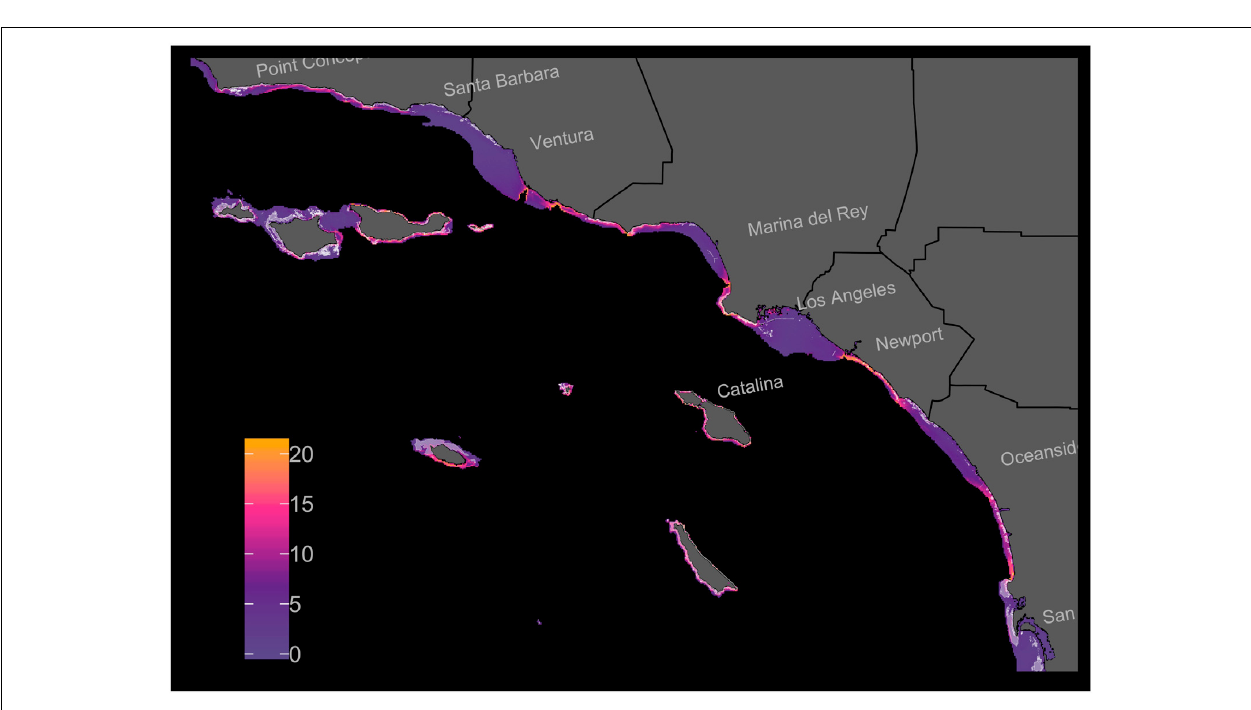
FIGURE 2 | Stacked-Species Distribution Model (s-SDM) showing predicted multi-species habitat suitability at a resolution of 200 × 200 m and within the 45 m isobath in the Southern California Bight. Individual-SDMs were created for 21 focal fish, invertebrate, and algal species across existing reef habitat and then projected across the entire study region. The individual-SDMs were then added together to create an s-SDM. Existing reef habitat shaded with white. Color ramp shows s-SDM